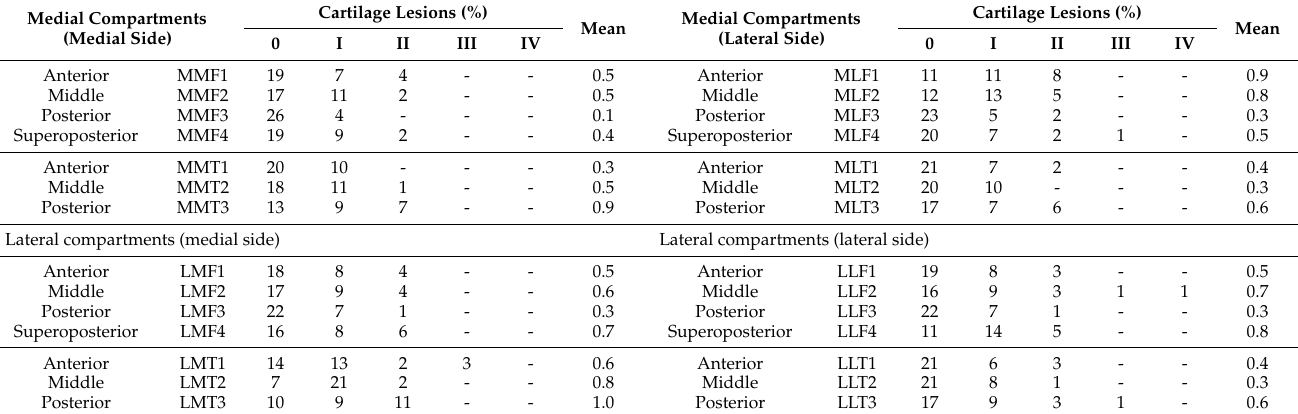
Table 1. CL distribution in subareas of the tibiofemoral compartments in the ACLR